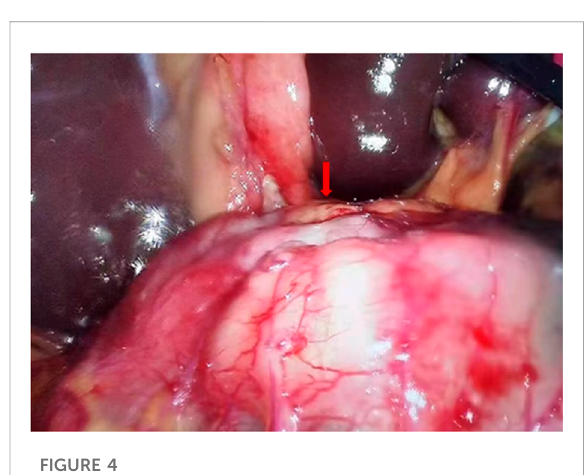
FIGURE 4 Laparoscopy exploration indicates visible tumor lesions, obviously at least penetrated the serosal